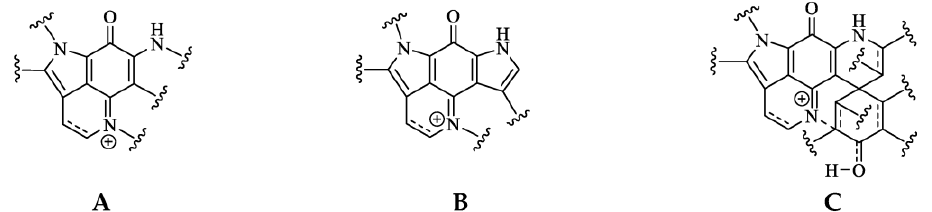
Figure 1. Pyrroloiminoquinone structural scaffolds ( A ) — Makaluvamines, ( B ) — Bispyrroloiminoquinones, ( C ) — Discorhabdins.